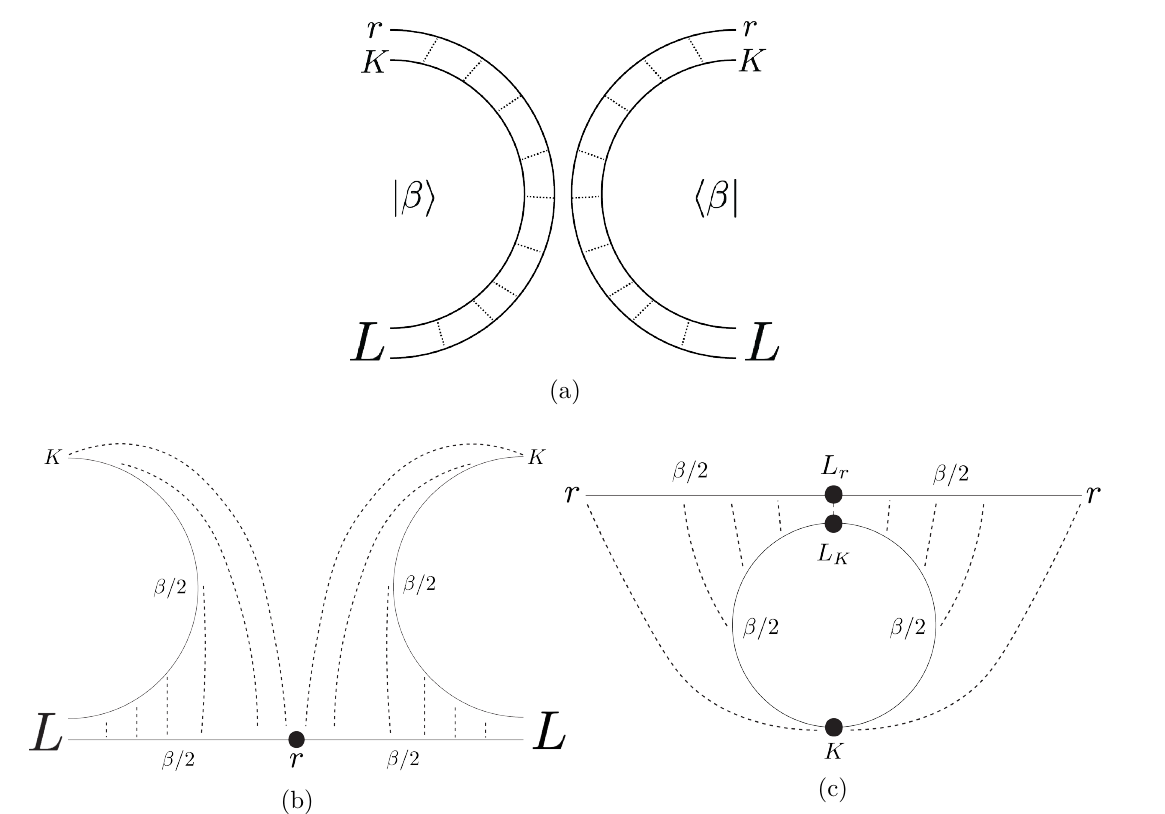
Figure 3. The top figure illustrates the path integral one must do to prepare the pure state density matrix | β i h β | . The bottom two figures illustrate tracing out subsystems from the TFD to produce a mixed state density matrix. In figure 3(b), we have traced out r to produce ρ LK , and in figure 3(c) we have traced out LK to produce ρ r . The dashed lines remind us that the two “wires” (contours) are coupled via Euclidean evolution with the SYK Hamiltonian. Thus, they tell us what parts of each wire have the same Euclidean time. Contours of Euclidean time length β/ 2 have been indicated. L r and L K refer to the image of r and K under Euclidean evolution by β/ 2